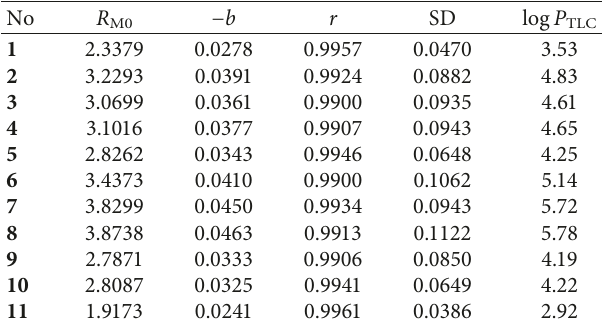
Table 2: The values of the R the equation R M � R M0 +( b)C and the value of log P TLC for the 1 – 11